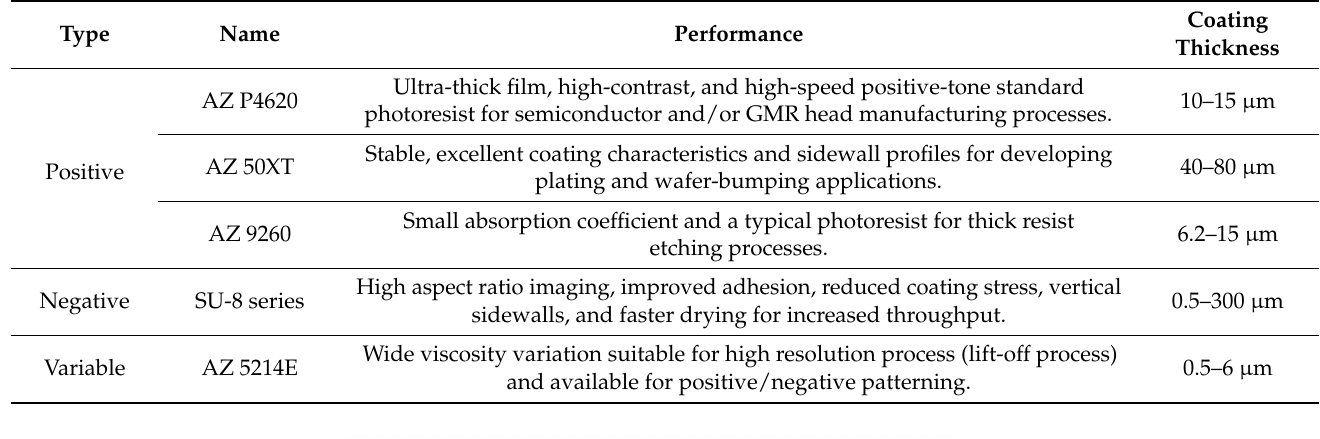
Table 7. The performance and coating thickness of common photoresists.